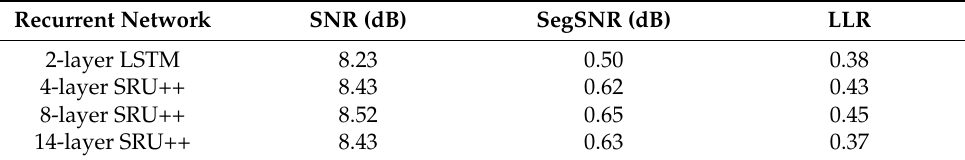
Table 1. Comparison of the model’s performance with 2-layer LSTM, 4-layer, 8-layer, and 14-layer SRU++ at 150 epochs.